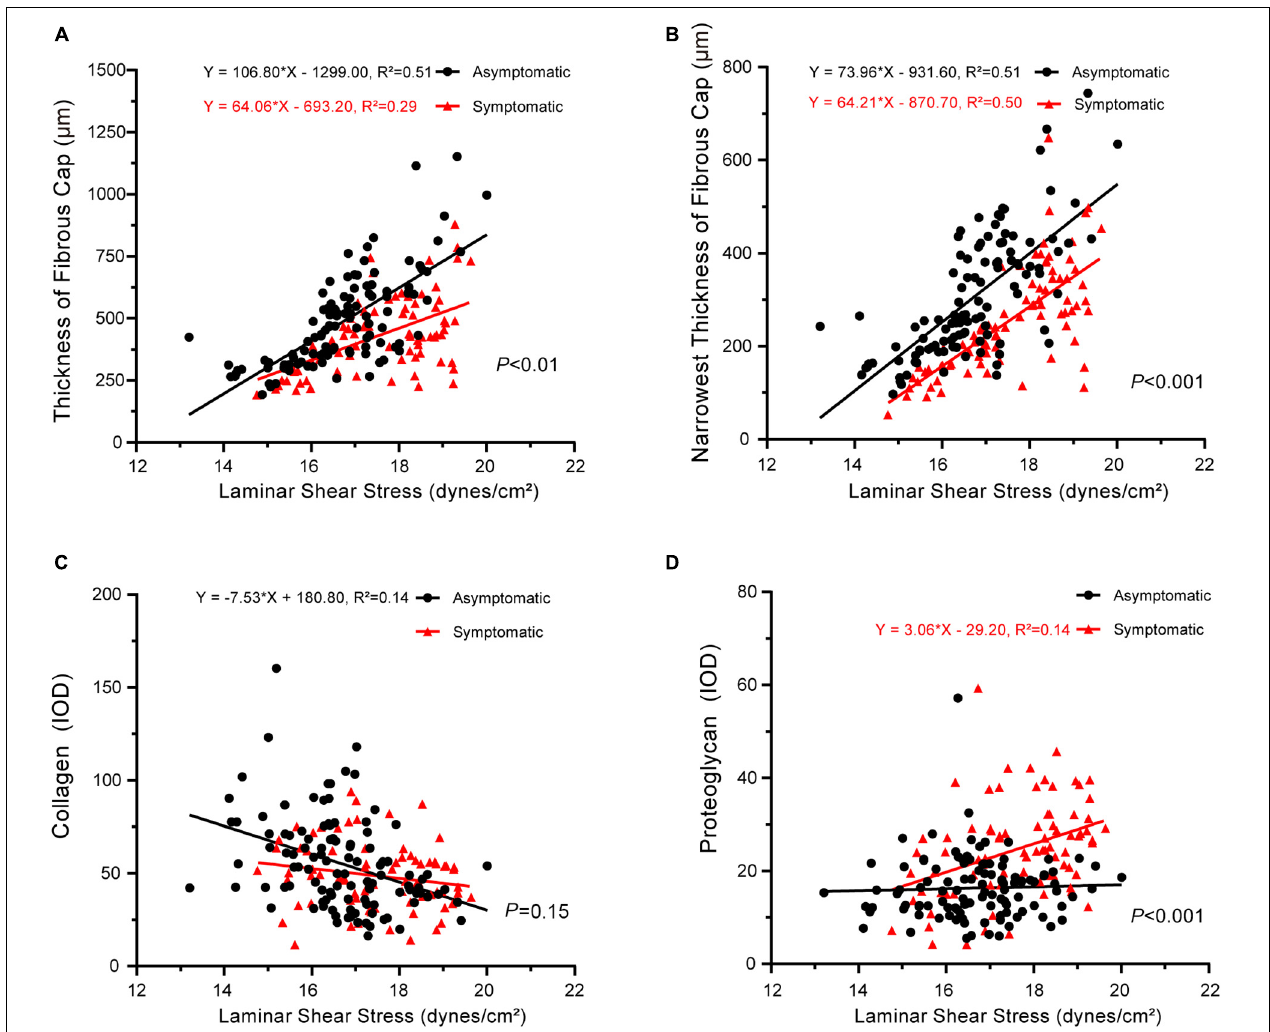
FIGURE 6 | Correlation between laminar shear stress and plaque pathology. (A) Linear regression model of fibrous cap thickness and laminar shear stress (asymptomatic: P < 0.001, R 2 = 0.51; symptomatic: P < 0.001, R 2 = 0.29); interaction between two groups had statistical significance ( P < 0.01). (B) Linear regression model of narrowest thickness of fibrous cap and laminar shear stress (asymptomatic: P < 0.001, R 2 = 0.51; symptomatic: P < 0.001, R 2 = 0.50); interaction between two groups had statistical significance ( P < 0.001). (C) Linear regression model of collagen and laminar shear stress (asymptomatic: P < 0.001, R 2 = 0.14; symptomatic: P > 0.05); interaction between two groups had no statistical significance ( P = 0.15). (D) Linear regression model of proteoglycan and laminar shear stress (asymptomatic: P > 0.05; symptomatic: P < 0.01, R 2 = 0.14); interaction between two groups had statistical significance ( P <